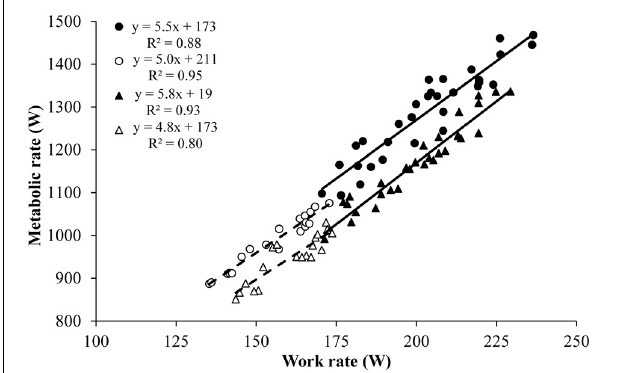
are shown for men (filled symbols, solid line) and women (open symbols, dashed line) and for the 5% (circular symbols) and 12% incline (triangular symbols). The correlation coefficients between gross efficiency at the two inclines were 0.55 and 0.72 for men and women respectively (both P < 0 .